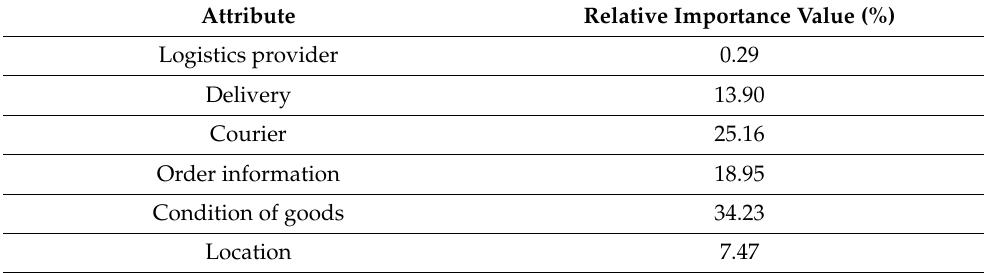
Table 7. Relative importance